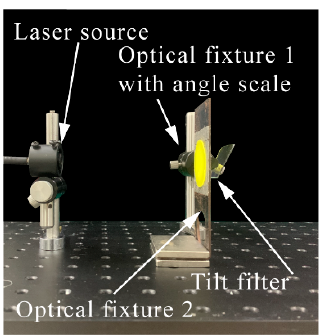
Figure 3. Configurations of the phosphor converters and actual lighting effects of the CPCs and AT- FPCs.